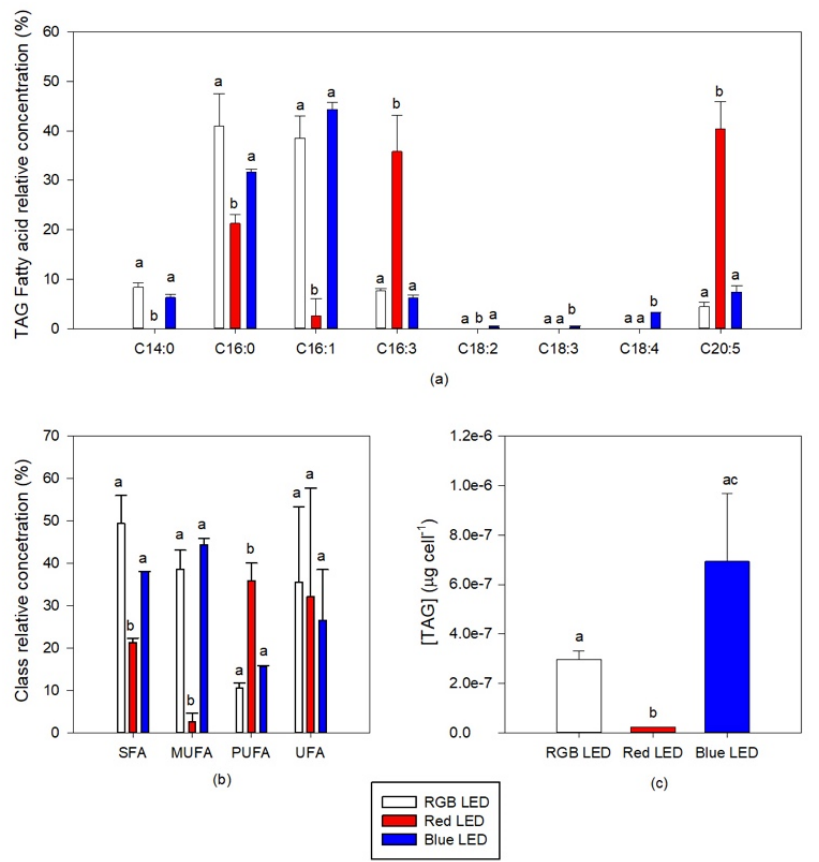
Figure 9. TAG fatty acid profile ( a ) saturation classes ( b ) and cellular content ( c ) of the P. tricornutum cultures ( N = 3) subjected to the three light treatments at the end of the 96 h exposure period (average ± standard error, letters denote significant differences between light treatments at p < 0.05).